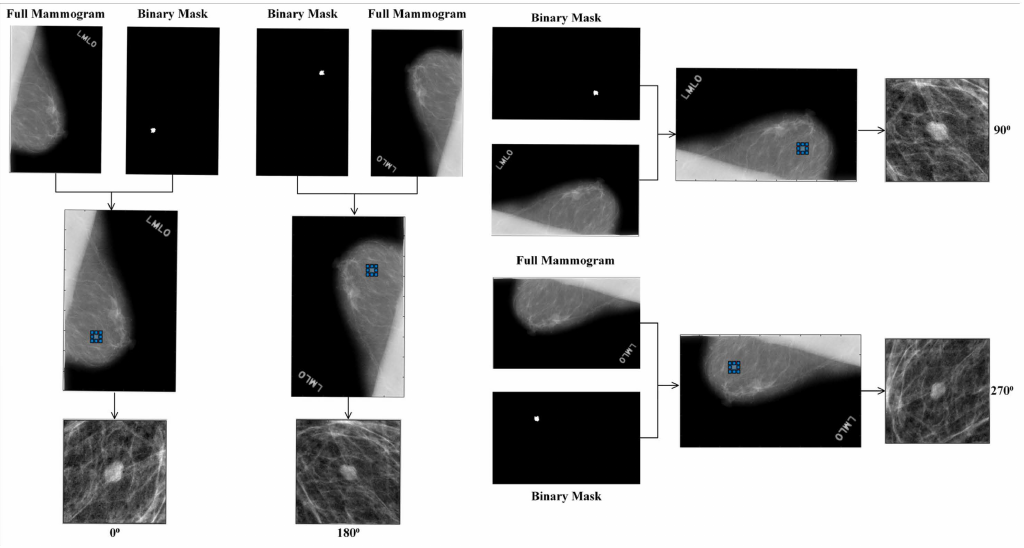
Figure 12. Extracted ROI with different